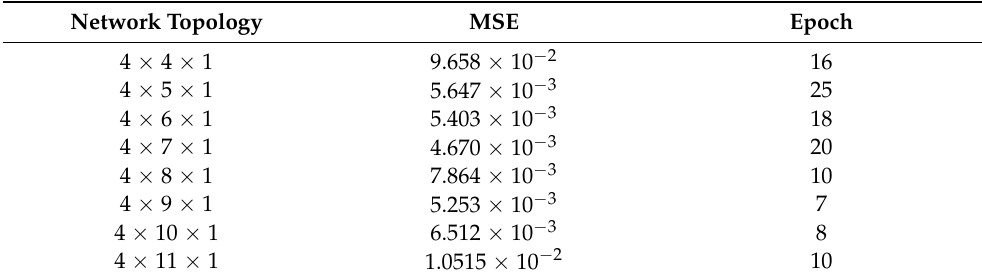
Table 3. Training result for BP artificial neural network with different neurons. Network